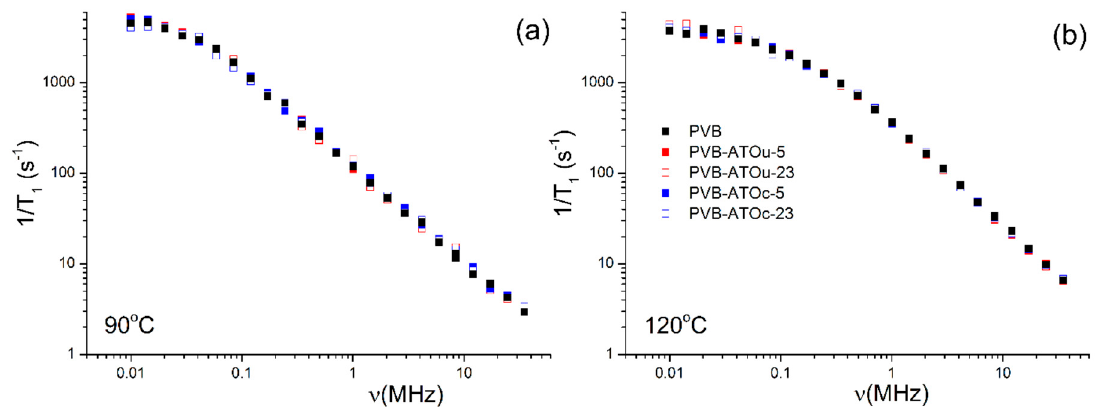
Figure 9. Comparison of the nuclear magnetic resonance relaxation dispersion (NMRD) curves exhibited by PVB and by the composites at ( a ) 90 ° C and ( b ) 120 ° C.